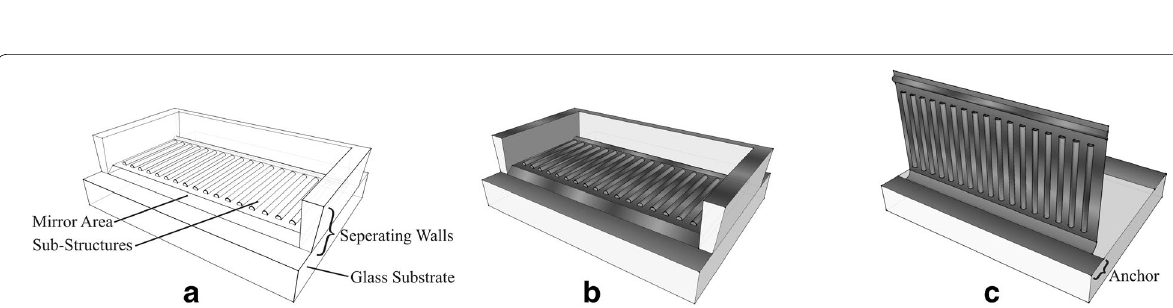
Fig. 3 A representative 3D sacrificial structure (with sub-structures design III) made of photoresist ( a ), after deposition of stressed aluminum layer depicted in grey ( b ), and released micromirror in non-actuated state ( c ). Insulator and transparent electrode are not shown